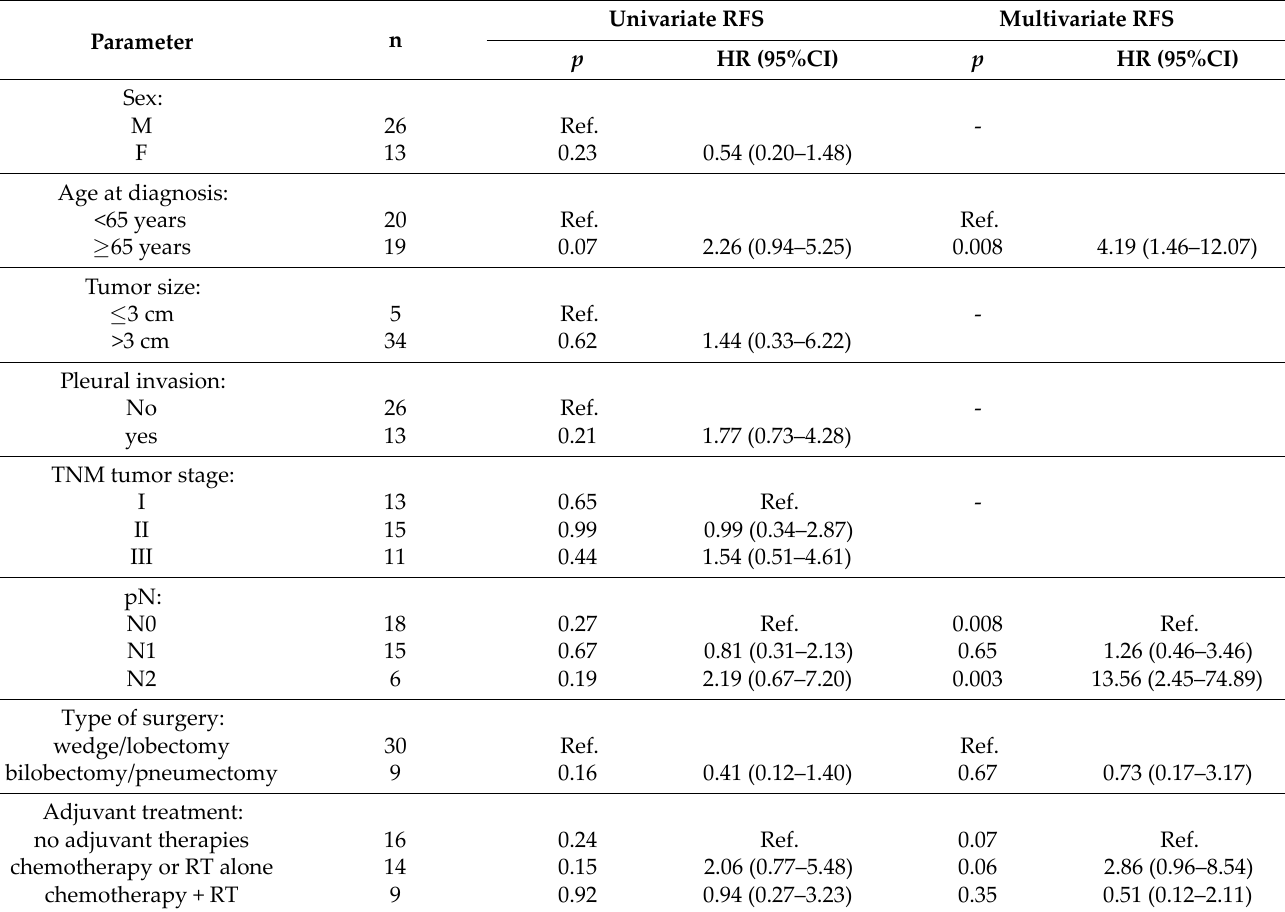
Table 3. Cox regression univariate and multivariate analysis of prognostic factors influencing recurrence‑free